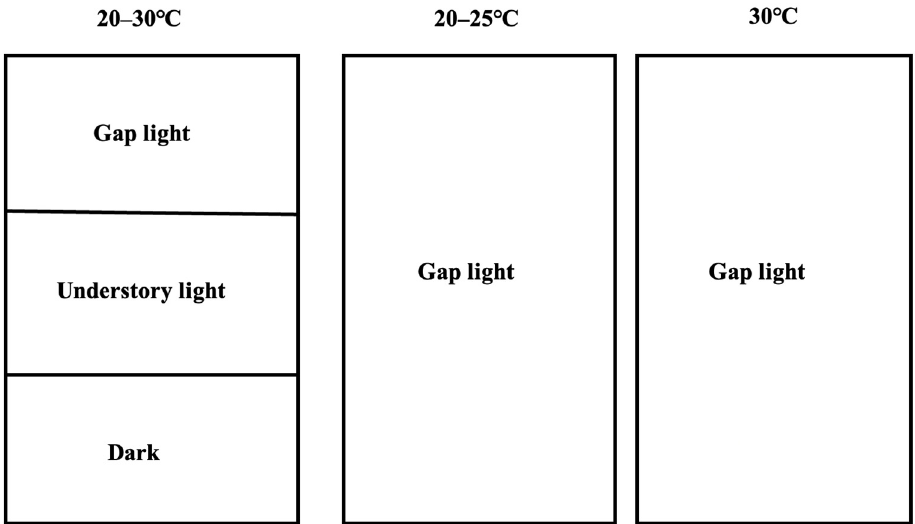
Figure 3. The design diagram for the seed germination experiments in artificial climate chambers.